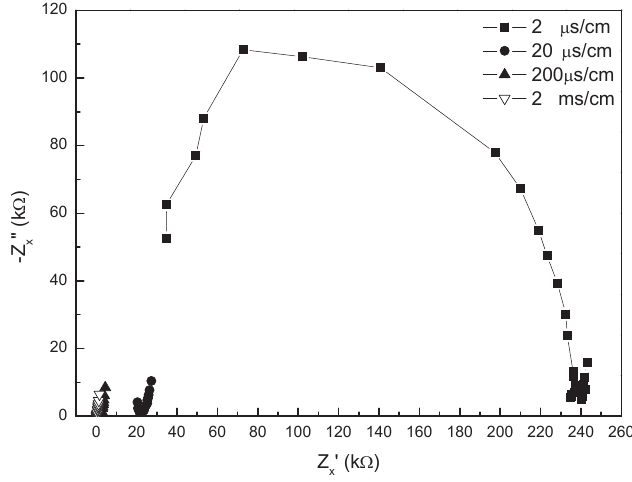
Figure 8. Nyquist plot of the measured impedance spectrum of the transducer for different solution